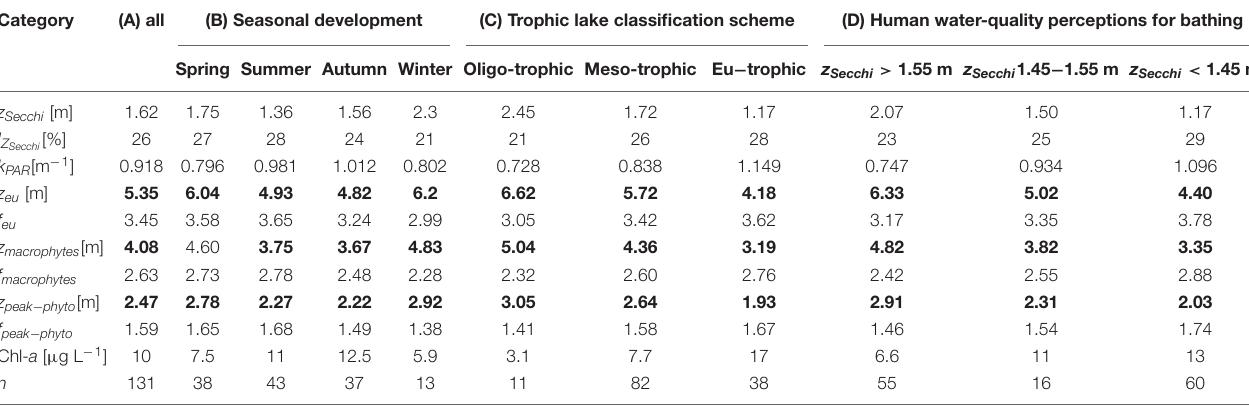
TABLE 2 | Optical water properties as Secchi disk transparency ( z Secchi ), the percentage of surface ambient light at z Secchi ( I Z ( k PAR ) satisfying light requirements for photosynthesis of phytoplankton and macrophytes and human perception to judge water suitability for bathing (satisfying water clarity for recreational